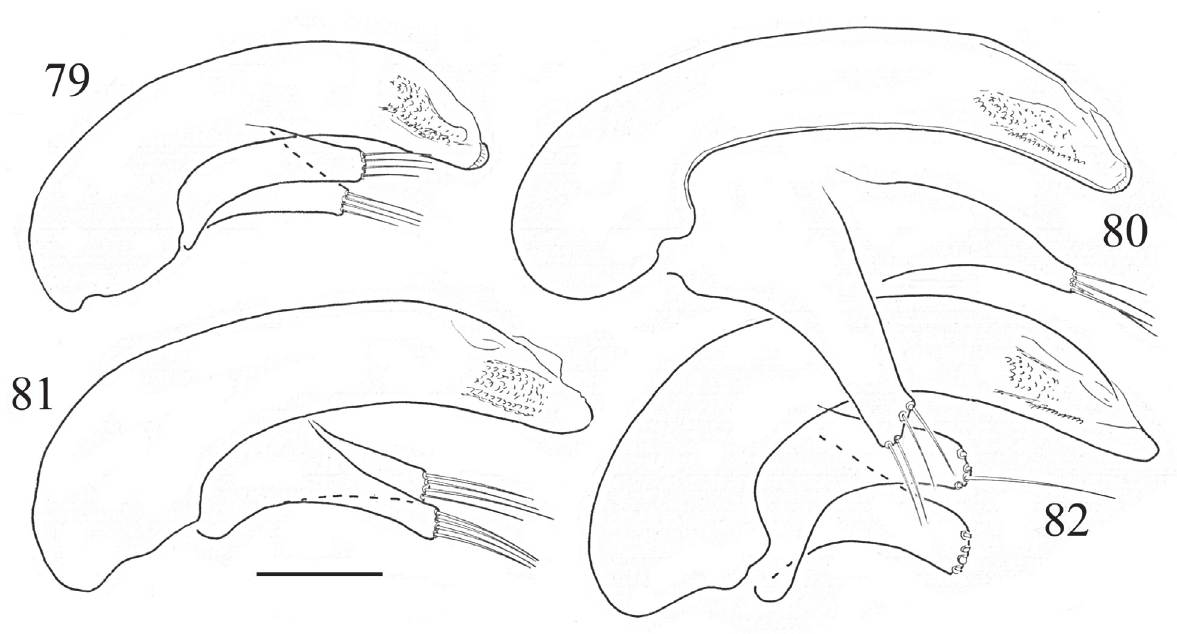
Figs 79-82. Aedeagus in lateral view of Trechistus spp.: 79) T. terricola Moore, ♂ from Lake Osborne; 80) T. humicola Moore, ♂ from Mt. Wellington; 81) T. gordoni n. sp., HT ♂ from Creepy Crawly Walk; 82) T. sylvaticus Moore, ♂ from Capricorn Cave. Scale: 0.1